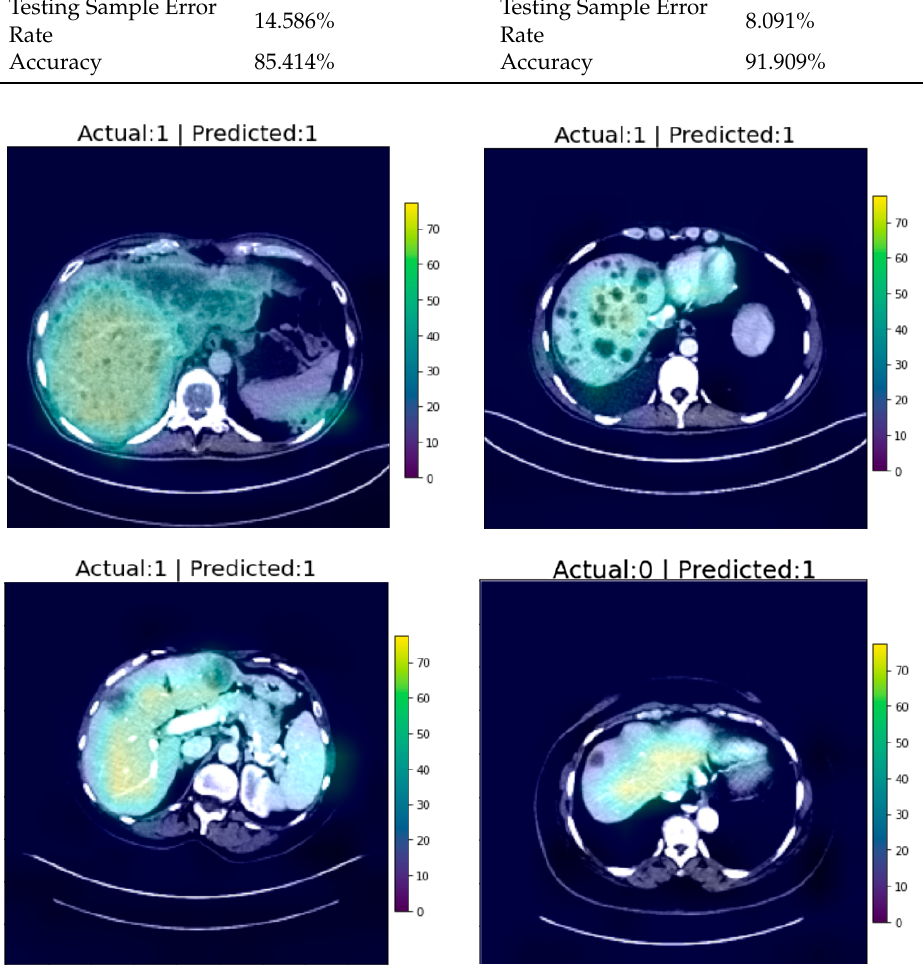
Figure 6. CT images with Grad-CAM-generated heat-maps overlaid.